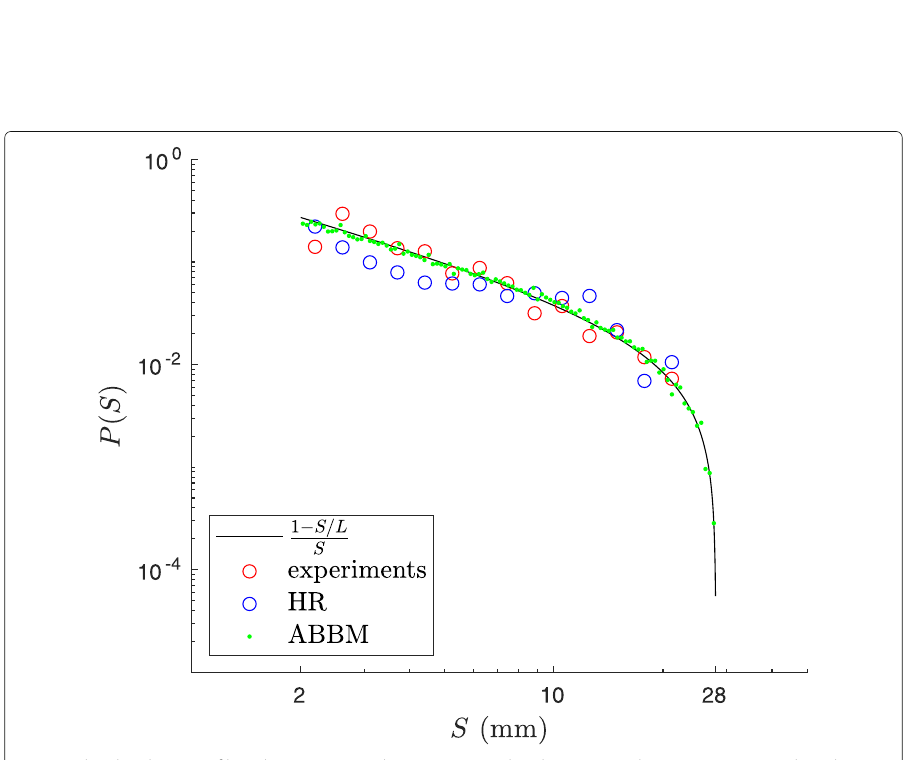
Fig. 5 The distribution of band propagation distances (or avalanche sizes) in the experiments (red) in the Hähner–Rizzi model simulations (blue), and the ABBM model simulations (green). The black line represents )/ S where A the expected form of the distribution P ( S ) = A ( 1 − S L